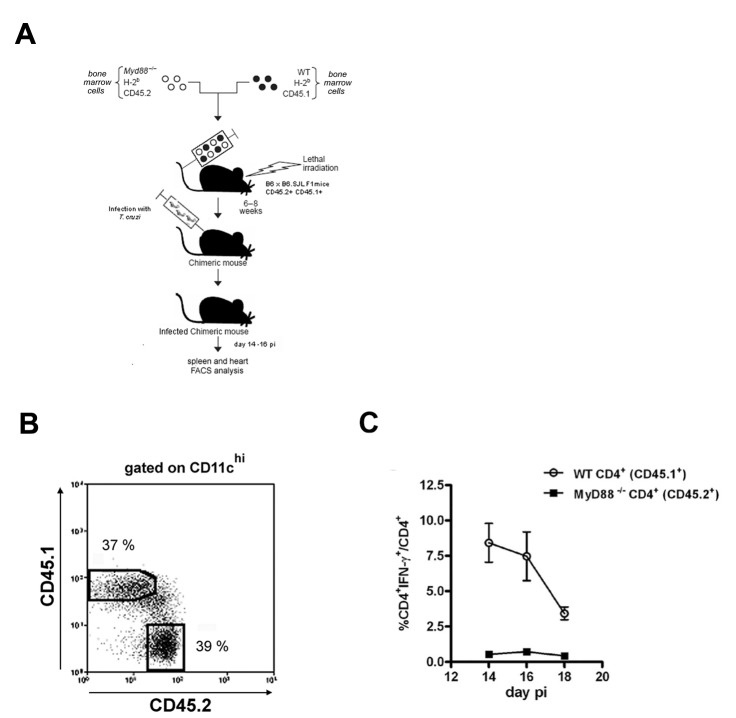
Mixed bone-marrow chimeras.(A) Experimental design for mixed BM chimera construction. Irradiated WT (B6 x B6.SJL F1) mice were reconstituted with a 1:1 mix of WT (B6.SJL, CD45.1+) and Myd88−/− (CD45.2+) BM cells. (B) Representative frequencies of CD45.1+ (B6.SJL, WT) and CD45.2+ (Myd88−/−) cells gated on CD11chi spleen cells of non-infected mixed BM chimeric mice. (C) Kinetics of the frequency of IFN-γ+CD4+ T cells among CD4+CD45.1+ WT (white circles) and CD4+CD45.2+Myd88−/− (black squares) splenocytes from infected mixed BM chimeric mice.